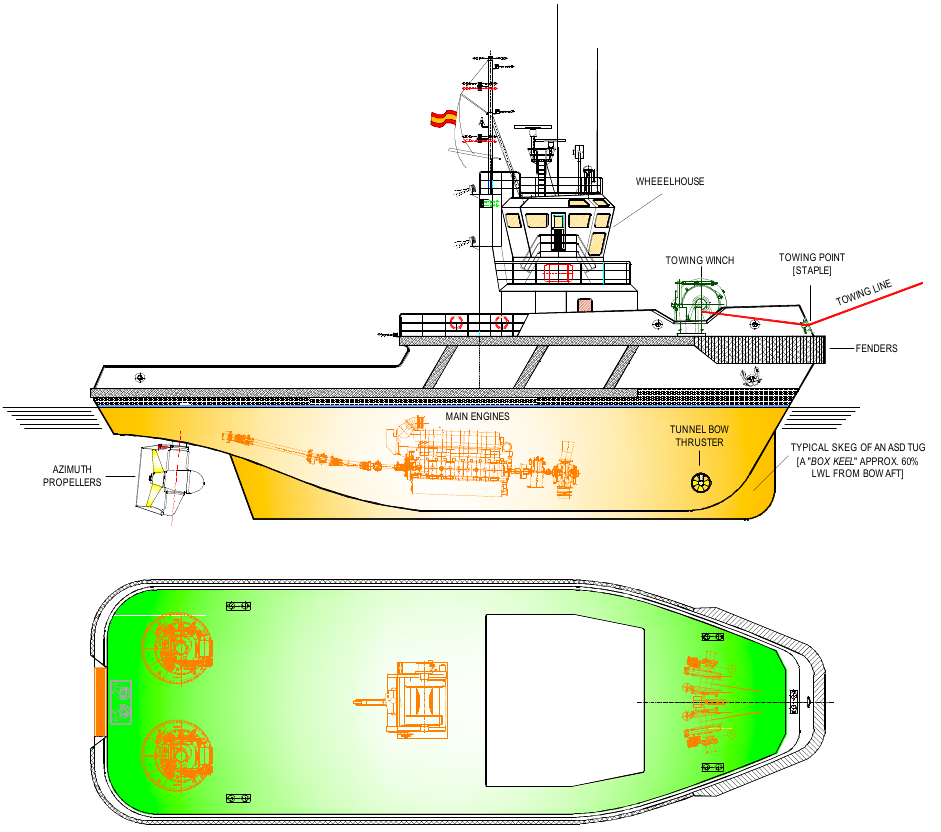
Figure 1. A typical Azimuthal Stern Drive (ASD) escort tug. Drawing: Authors. The typical skeg of a modern ASD escort tug, necessary to generate hydrodynamic forces, does not have the high aspect ratio of a tractor tug, for hull geometric reasons, but a box keel located approximately 60% of the waterline length along from the bow aft. This appendix is used